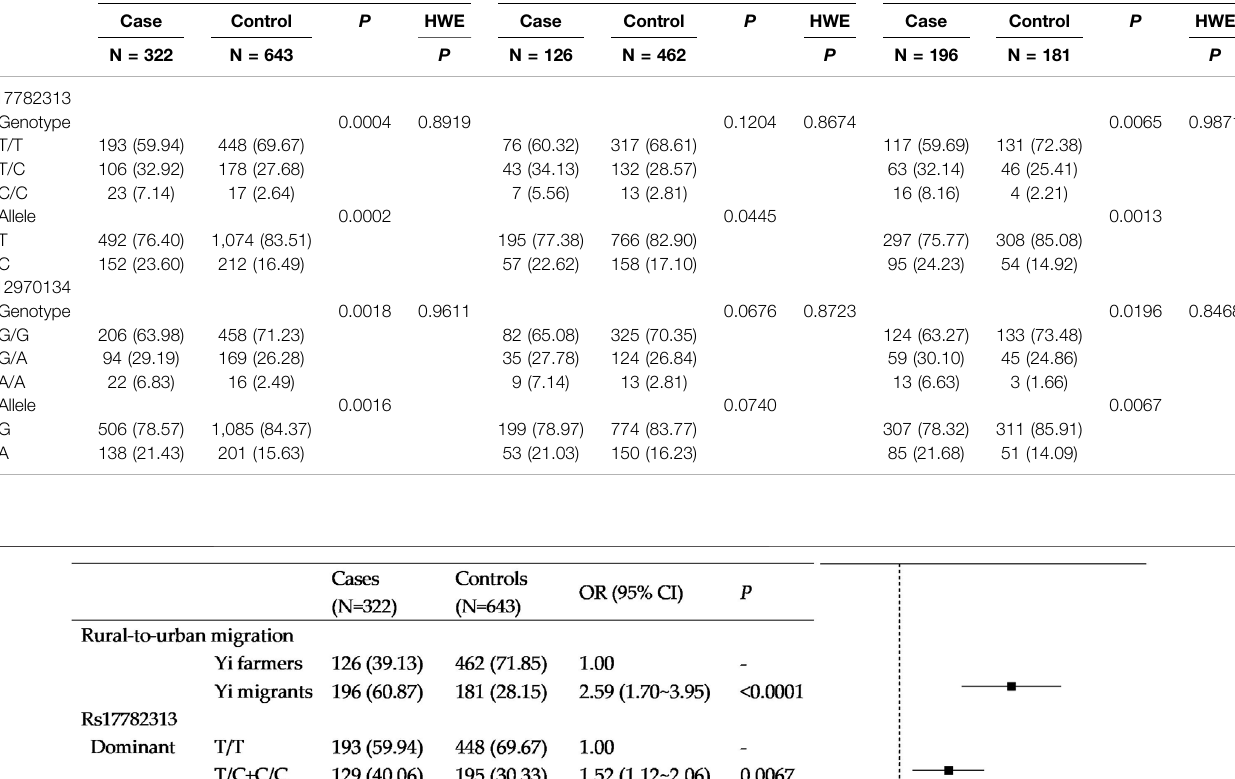
had a high education and income level. Except for the drinking status, the lifestyle factors between the case and control groups were signi fi cantly different. Strati fi ed descriptions of the